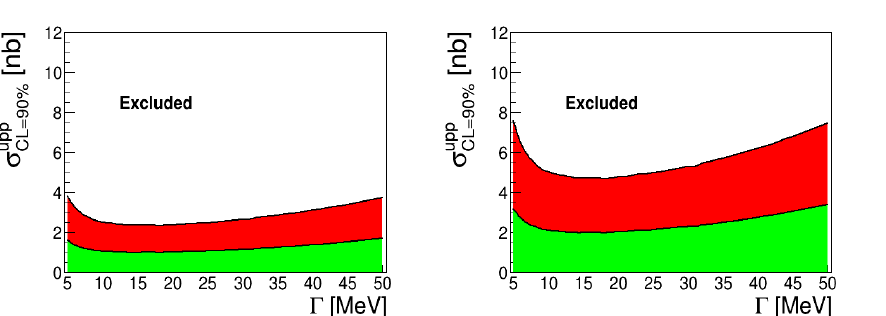
Figure 1. Upper limit of the total cross-section for dd → ( 4 He- η ) bound → 3 He n π 0 (left panel) and dd → ( 4 He- η ) bound → 3 He p π − (right panel) reaction as a function of the width of the bound state. The binding energy was fixed to 30 MeV. The upper limit was determined via the simultaneous fit for both channels. The green area denotes the systematic uncertainties. The figures are adopted from